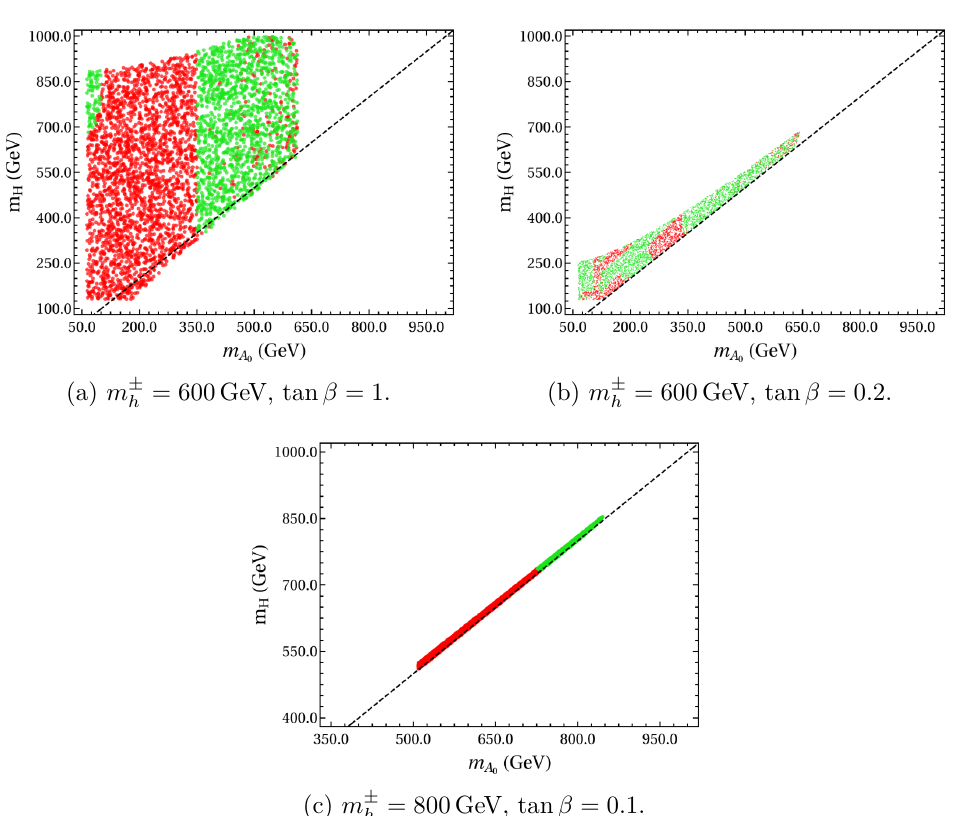
Figure 8 . Collider constraints for the allowed range of masses for extra neutral scalars. In red we show the excluded points, while in green the allowed ones at 95% C.L. Values for m are chosen as shown in the plots. The black dashed line is for degenerate masses. All points comply with theoretical constraints.